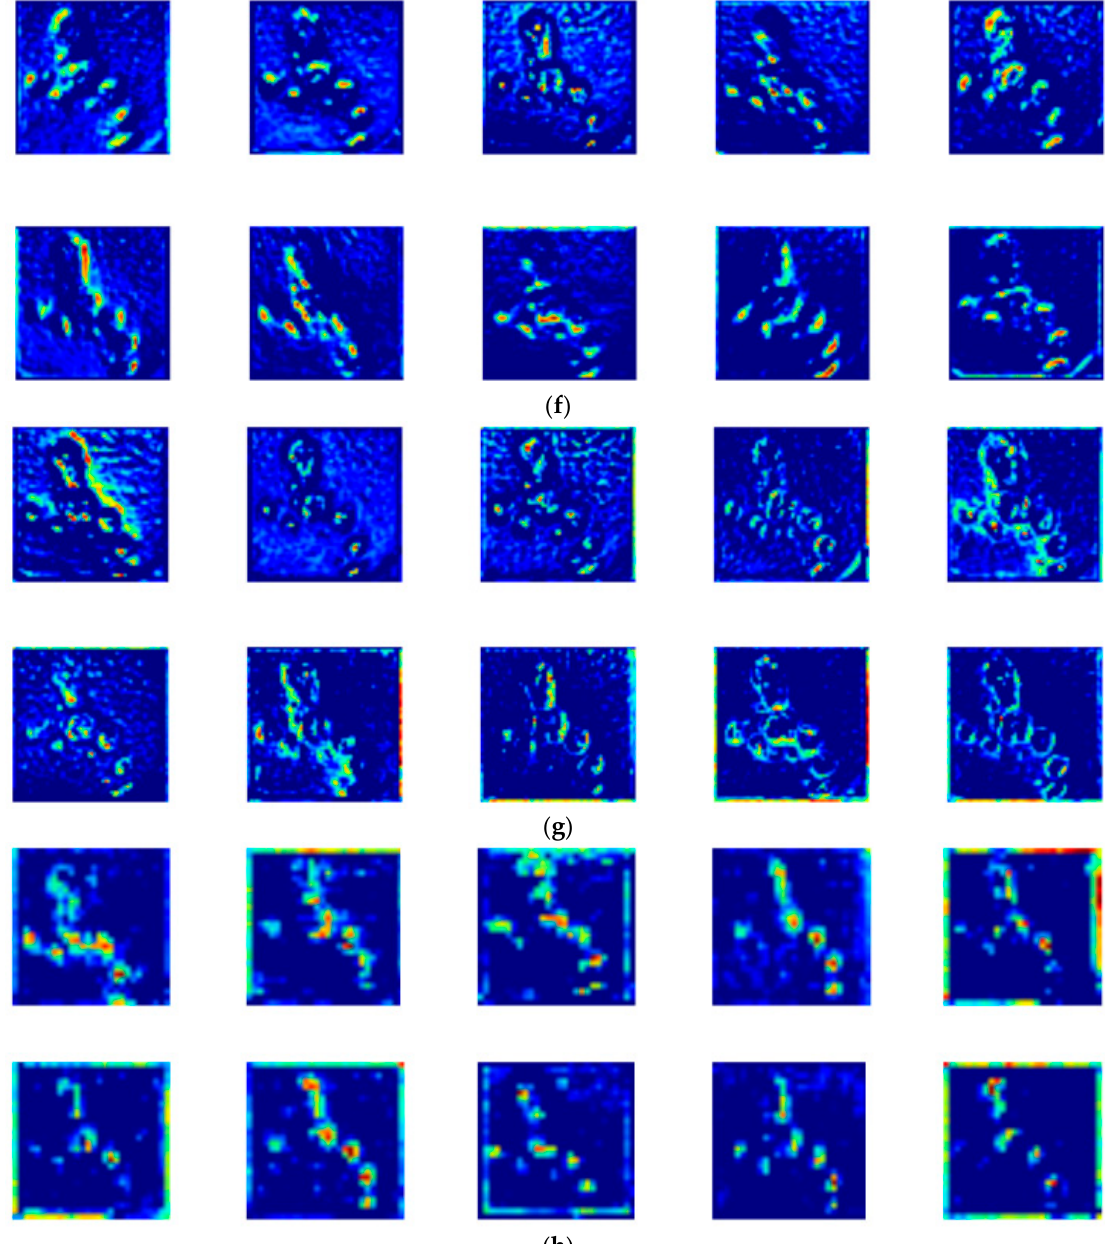
Figure 10. Visualization of features. ( a ) and ( e ) input images, ( b ) and ( f ) output features of the intermediate building block 1, ( c ) and ( g ) sampled features of the intermediate building block 2, ( d ) and ( h ) examples of the feature maps in the intermediate building block 3. Brighter color in images corresponds to higher value.